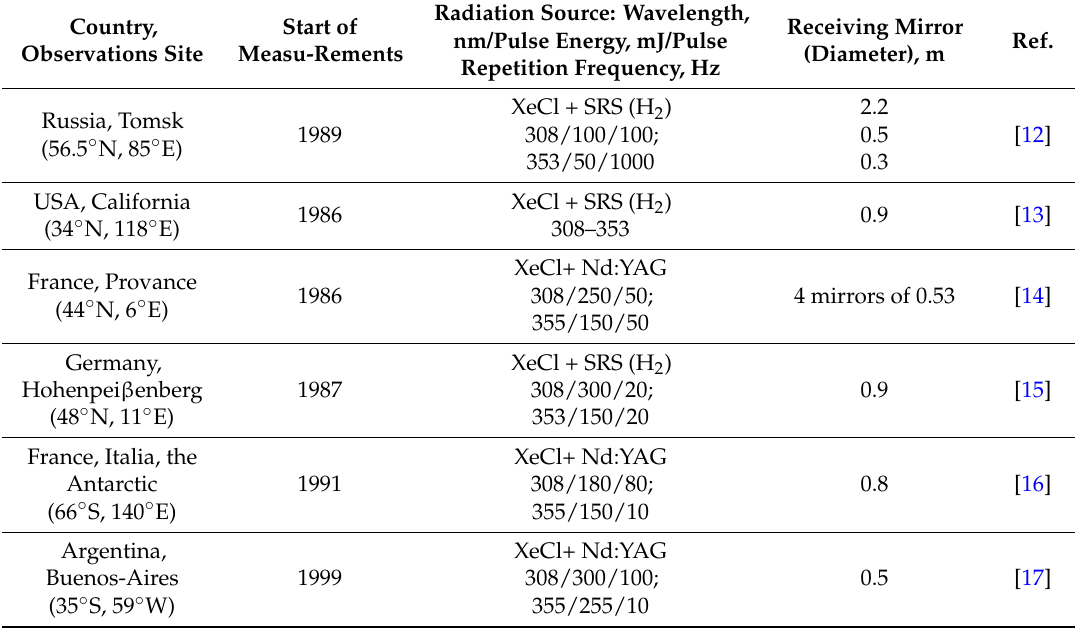
Table 1. Specifications of lidars used for measurements of stratospheric